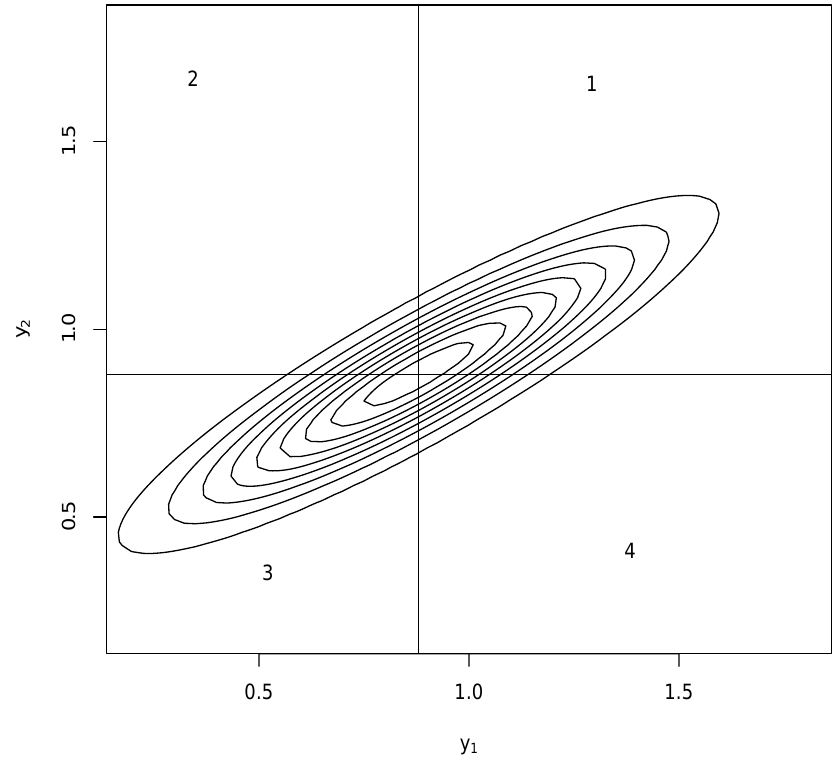
Figure 1. Contours of example bivarate normal density of y is likely to fall outside the range of y in region 1 or